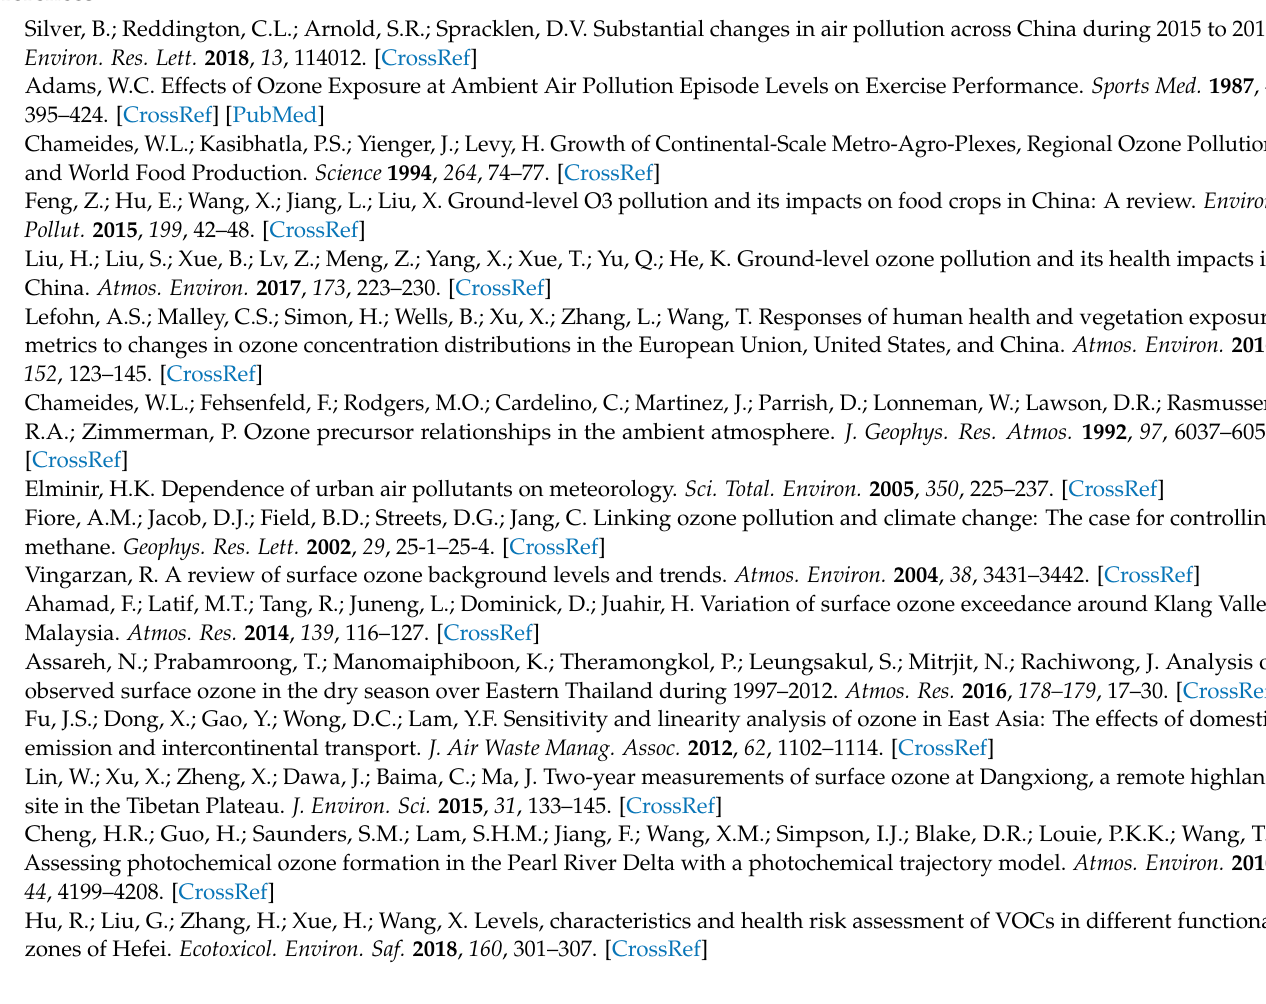
of observed and fitted values) in GAM model during O 3 episodes in 2018, Figure S10: Residual error result test ((a) Residual QQ plot,(b) Residual histogram,(c) Scatter plot of residuals and predictions,(d) Scatter plot of observed and fitted values) in GAM model during O 3 episodes in 2019, Figure S11: Residual error result test ((a) Residual QQ plot,(b) Residual histogram,(c) Scatter plot of residuals and predictions,(d) Scatter plot of observed and fitted values) in GAM model during O 3